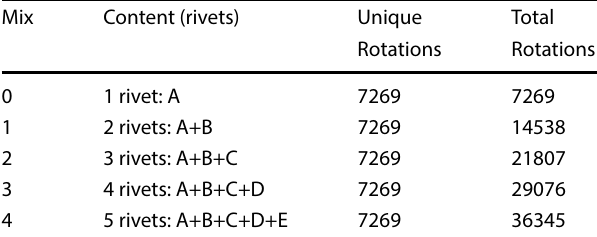
Table 2 Data sets and their number of both unique and total rota- tions Mix